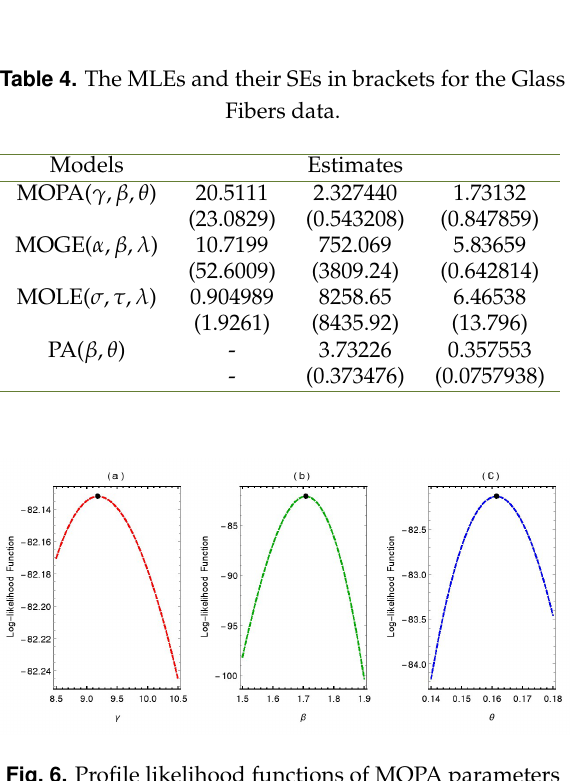
Fig. 6. Profile likelihood functions of MOPA parameters for Turbocharger data.